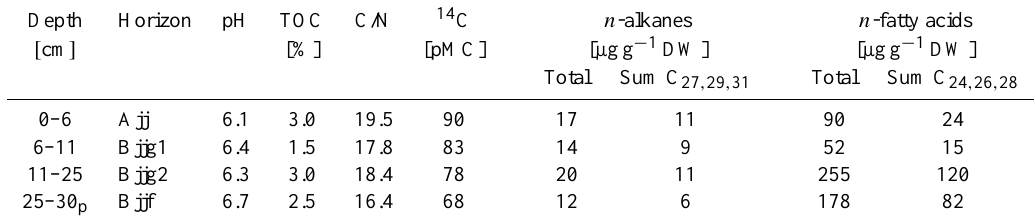
Table 1. Bulk soil properties in different depths intervals of a polygonal rim (Glacic Aquiturbels, FAO, 2007) on Samoylov Island, Siberia. Total extractable n -alkanes (C 19 –C 33 ) and n -fatty acids (C 14 –C 30 ) and summed long-chain, mainly plant-wax-derived n -alkanes (C 27 , C 29 , C 31 ) and n -fatty acids (C 24 , C 26 , C 28 ) are related to soil dry weight